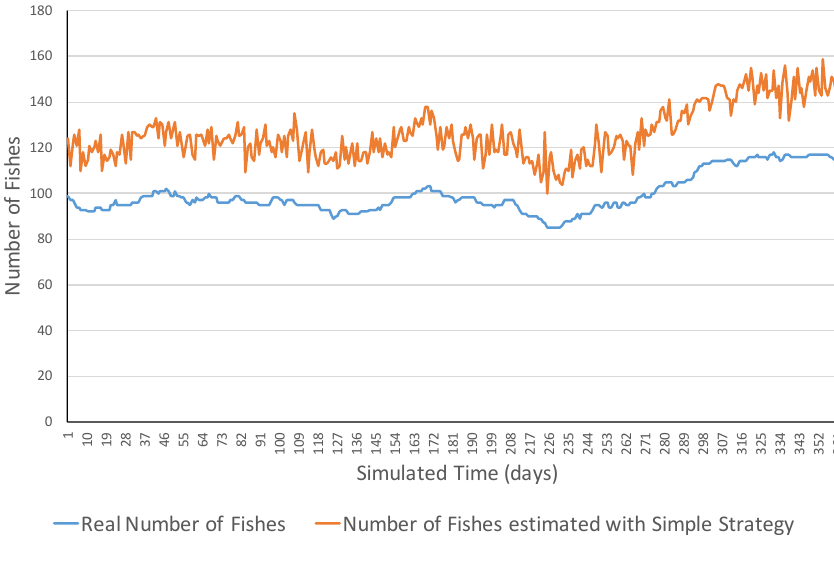
Figure 2. Simulation evolution of a neutral ecosystem with the simple